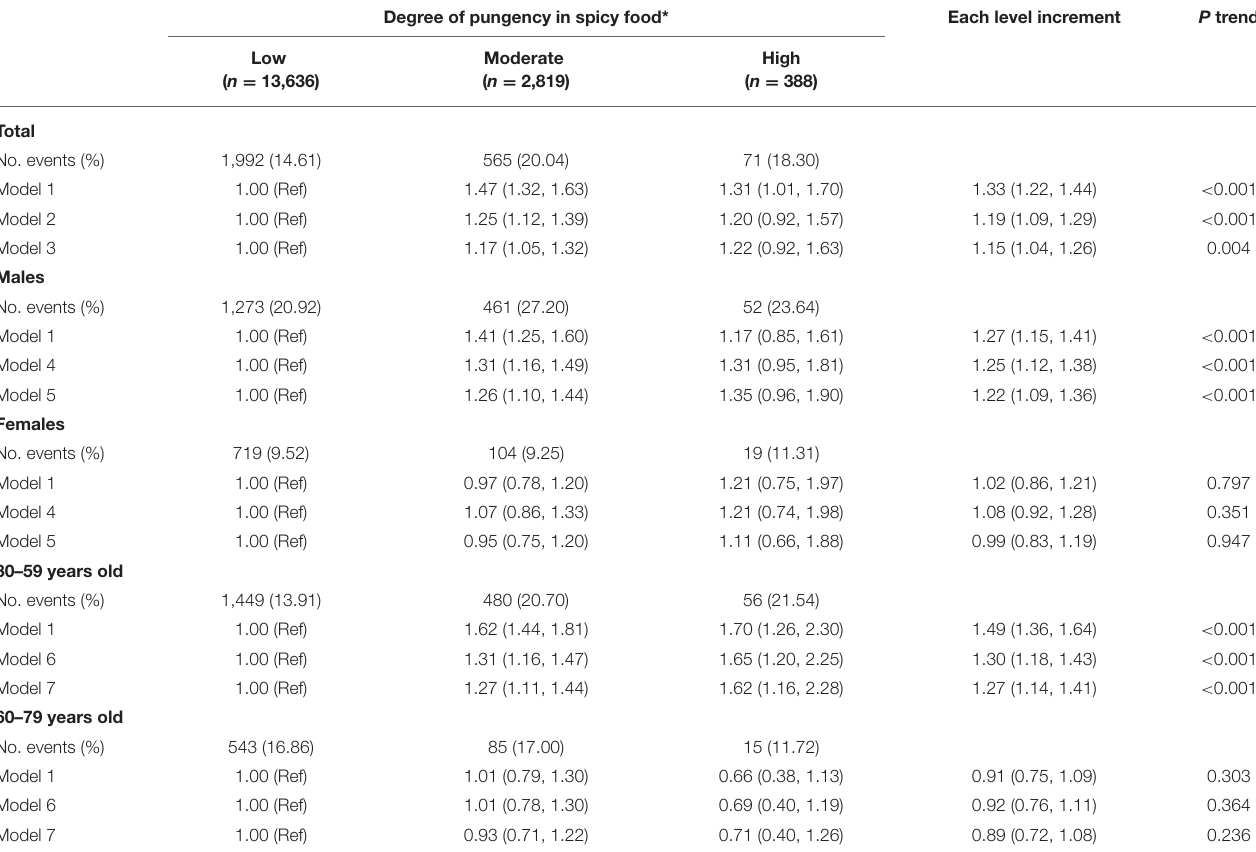
TABLE 3 | Multivariable-adjusted associations (ORs and 95% CIs) between degree of pungency in spicy food consumption and risk of hyperuricemia ( N = 16,843). Degree of pungency in spicy food* Each level increment P